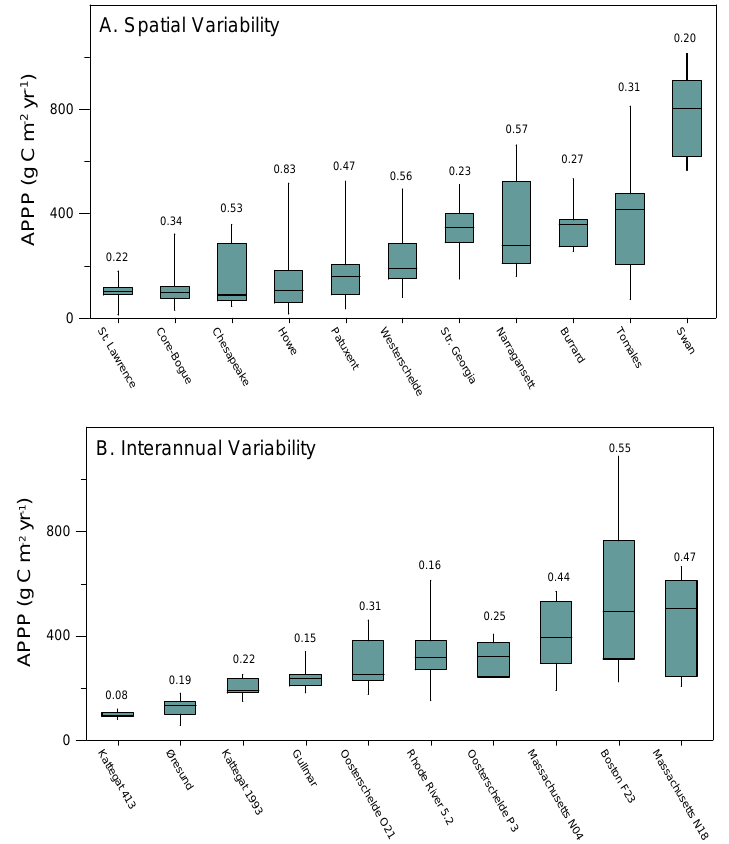
Fig. 5. Examples of ( A ) spatial variability of APPP across multiple sites within estuarine-coastal ecosystems, and ( B ) interannual variability of APPP at individual sites. Boxplots show median, interquartile ranges (boxes), and ranges (vertical lines). Numbers above are median absolute deviation (MAD) divided by median APPP for individual ecosystems or sites. These compare to MAD:median of 0.74 between ecosystems in ( A ) and 0.34 between sites in ( B ). ( A ) Lower St. Lawrence River Estuary (Therriault and Levasseur, 1985); Core-Bogue Estuarine system (Williams and Murdoch, 1966); Chesapeake Bay in the 1960s (Flemer, 1970); Howe Sound (Stockner et al., 1977); Patuxent River Estuary (Flemer et al., 1970); Westerschelde (Kromkamp et al., 1995); Strait of Georgia (Stockner et al., 1979); Narragansett Bay (Oviatt, 2002); Burrard Inlet (Stockner and Cliff, 1979); Tomales Bay (Cole, 1989); and Swan River Estuary (Thompson, 1998). ( B ) Kattegat sites 413 and 1993 (Carstensen et al., 2003); Øresund (Ærtebjerg, 1981); Gullmar Fjord (O. Lindahl, personal communication, 25 June 2009); Oosterschelde sites O21 and P3 (Wetsteyn and Kromkamp, 1994); Rhode River site 5.2 (Gallegos, 2014); Massachusetts Bay sites N04 and N18 and Boston Harbor site F23 (Oviatt et al.,